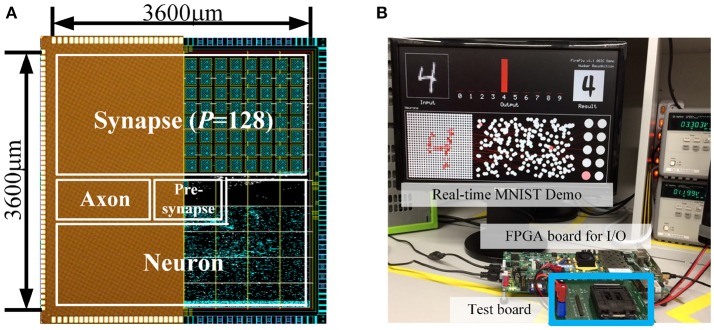
(A) Die microphotograph and layout of the design (65 nm CMOS) and (B) Demo & measurement environment.